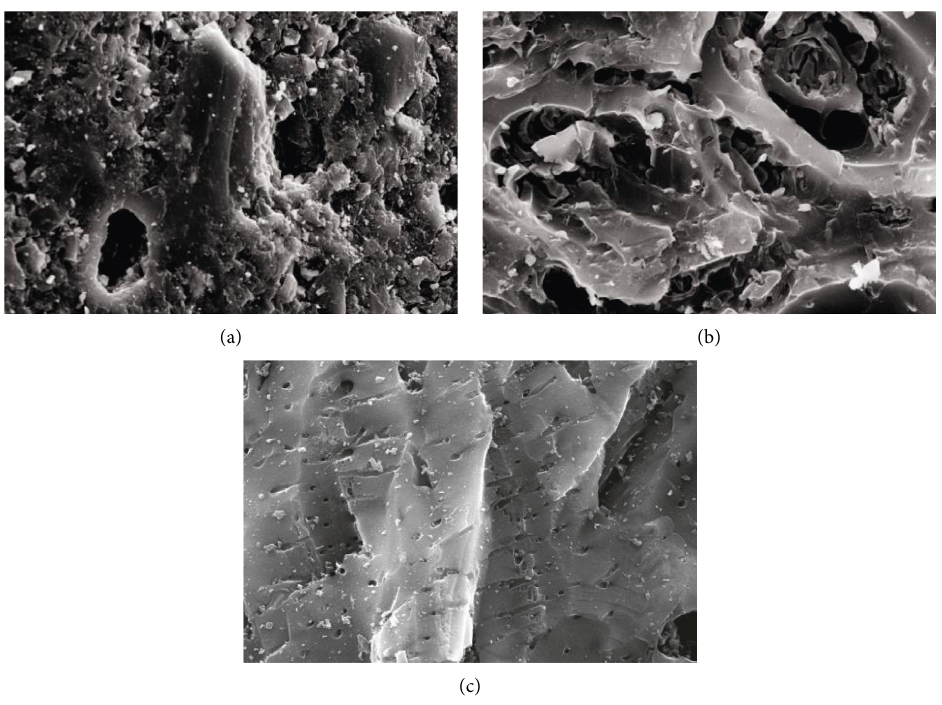
Figure 4: SEM of (a) the carbon precursor, (b) sludge carbon, and (c) activated carbon.